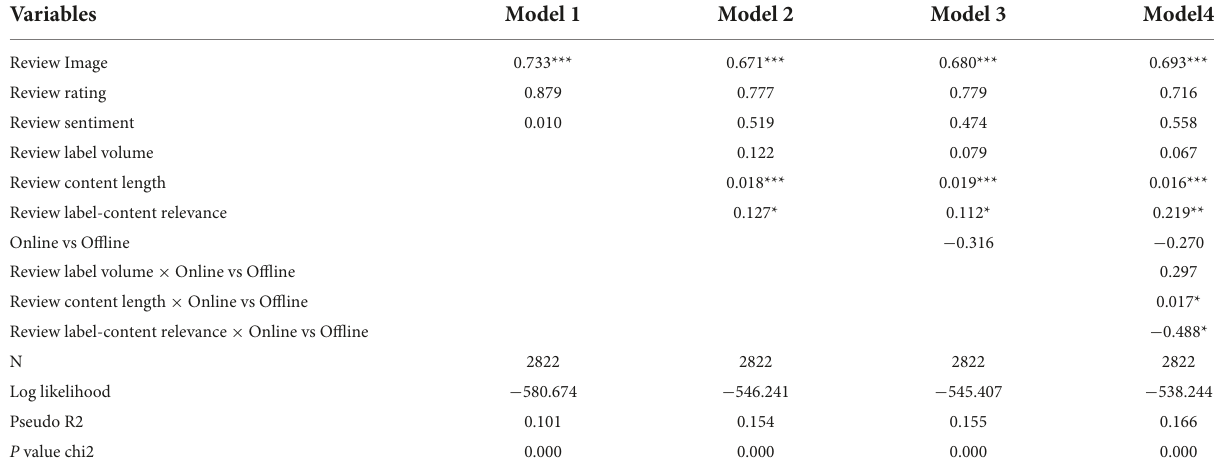
TABLE 2 Negative binomial regression results for review helpfulness.